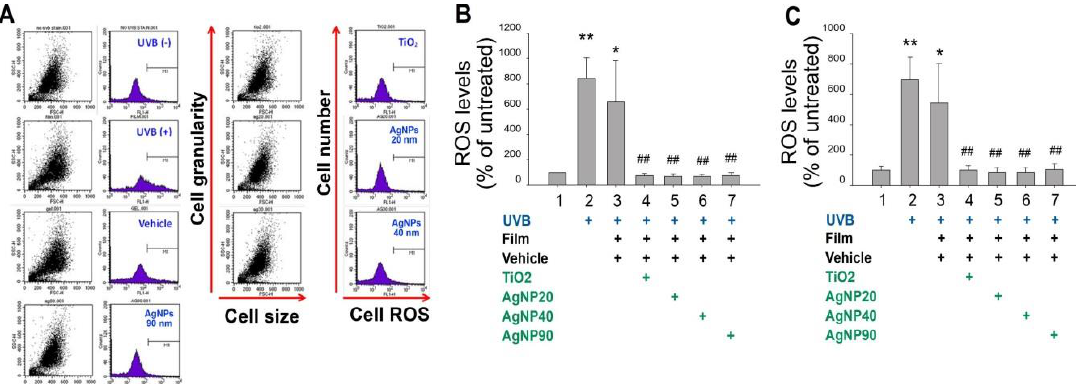
Figure 3. AgNPs rescue UVB-mediated induction of high cellular ROS levels in HaCaT keratinocytes. Flow cytometry ( A , B ) and fluorescence microplate reader ( C ) analyses of relative HaCaT cellular ROS levels after UVB irradiation using dichloro-dihydro-fluorescein diacetate (DCFH–DA) labeling. UVB, ultraviolet B; AgNP, silver nanoparticle; TiO 2 , titanium dioxide; ROS, reactive oxygen species. * p < 0.05, ** p < 0.01 vs. UVB (−) groups; ## p < 0.01 vs. vehicle groups.